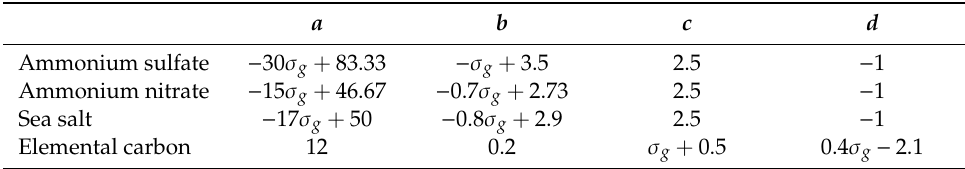
Table 3. Determined coe ffi cients ( a , b , c , and d) of mass extinction e ffi ciency in Equation (6) as a function of geometric standard deviation σ g